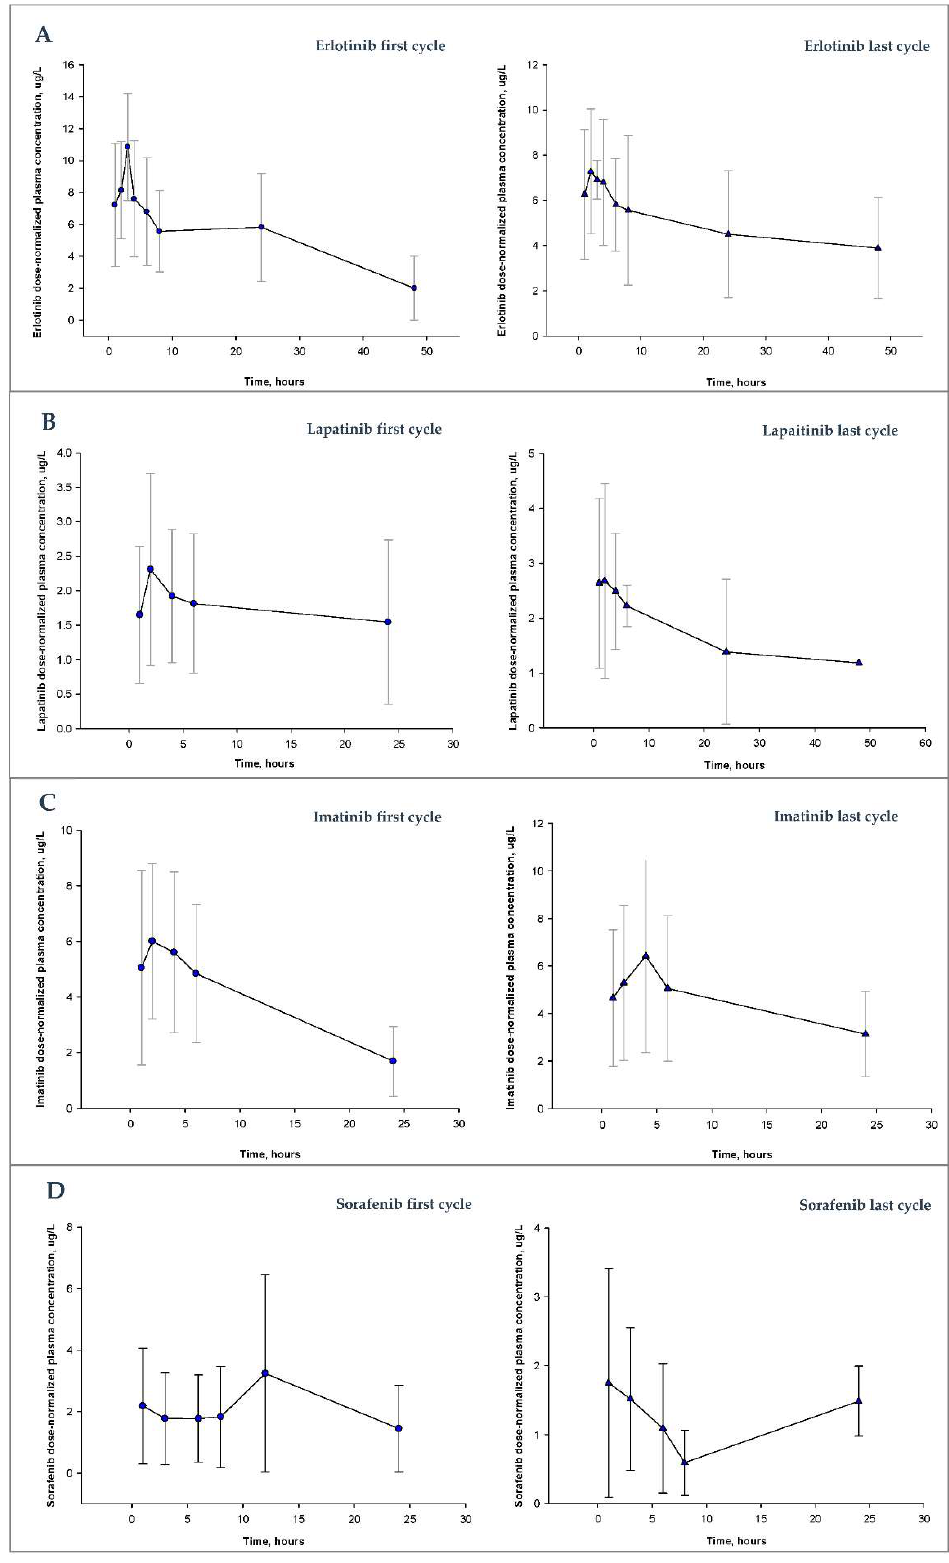
Figure 1. Dose-normalized plasma concentration profiles after administration of drug to patients receiving the dose of erlotinib ( A ), lapatinib ( B ), imatinib ( C ) or sorafenib ( D ) in the first or last monitored cycle. The symbols (circles and triangles) represent the mean dose-normalized plasma concentrations of patients at different times. The error bar for each point represents the standard deviation for each mean.